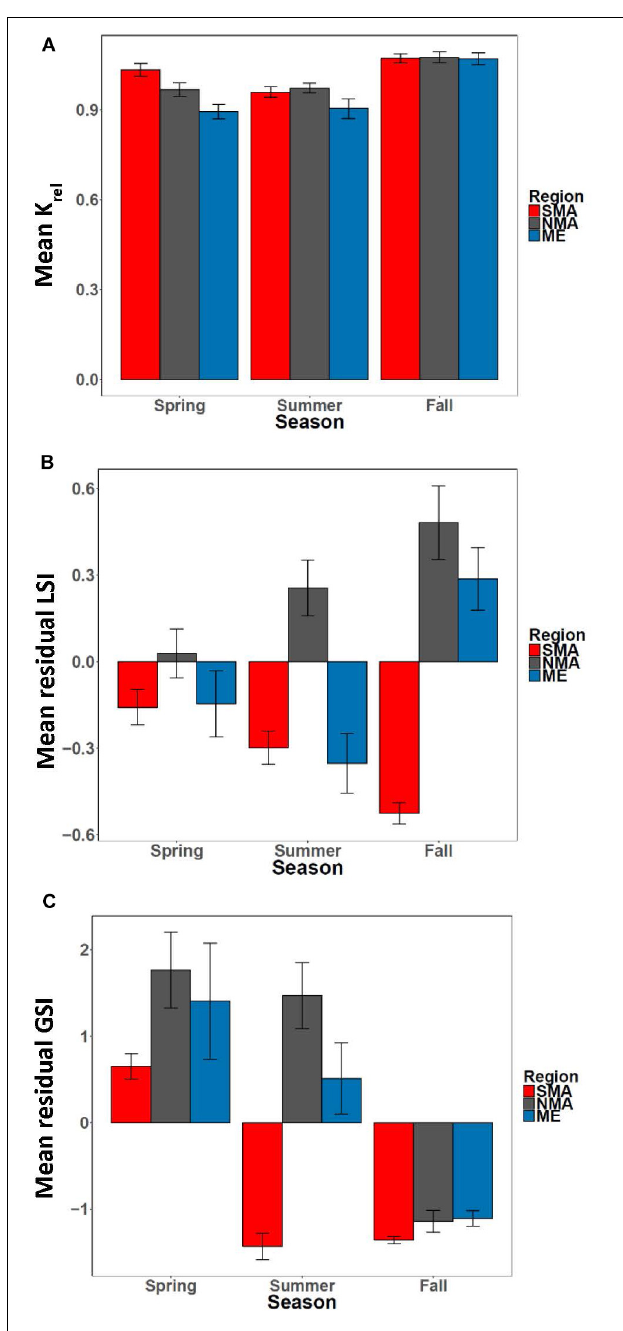
FIGURE 6 | (A) Mean Krel, (B) mean residual LSI and (C) mean residual GSI by season for Maine (ME), northern Massachusetts (NMA) and southern Massachusetts